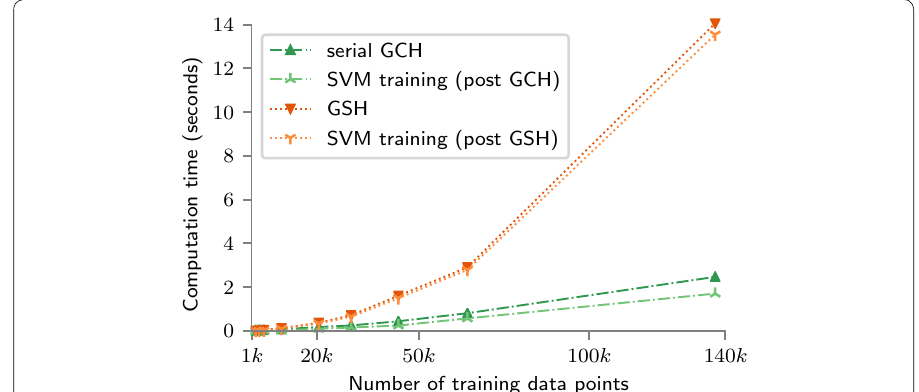
Fig. 21 Partitions after GCH